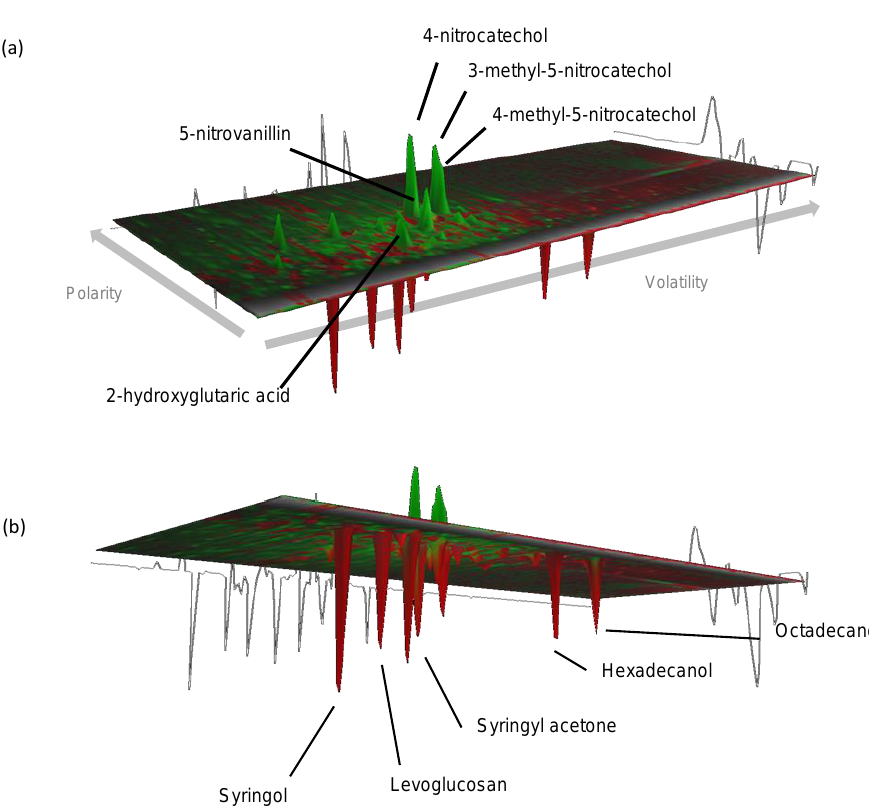
Figure 5. Overview of the changes occurring in the chemical fingerprint at the molecular level of biomass burning organic aerosol (BBOA) during atmospheric aging. Organic markers forming (green) or decaying (red) during aging. The figure is a three-dimensional representation of the difference in intensity of the peaks (normalized to the signal of the internal standards) calculated between aged (integrated OH exposure of 5 × 10 6 moleculescm − 3 h) and fresh samples. The samples were collected on quartz fiber filters and analyzed with GC × GC EI-HR-ToF-MS (see SI). Panel (a) is viewed from the top and (b) from the